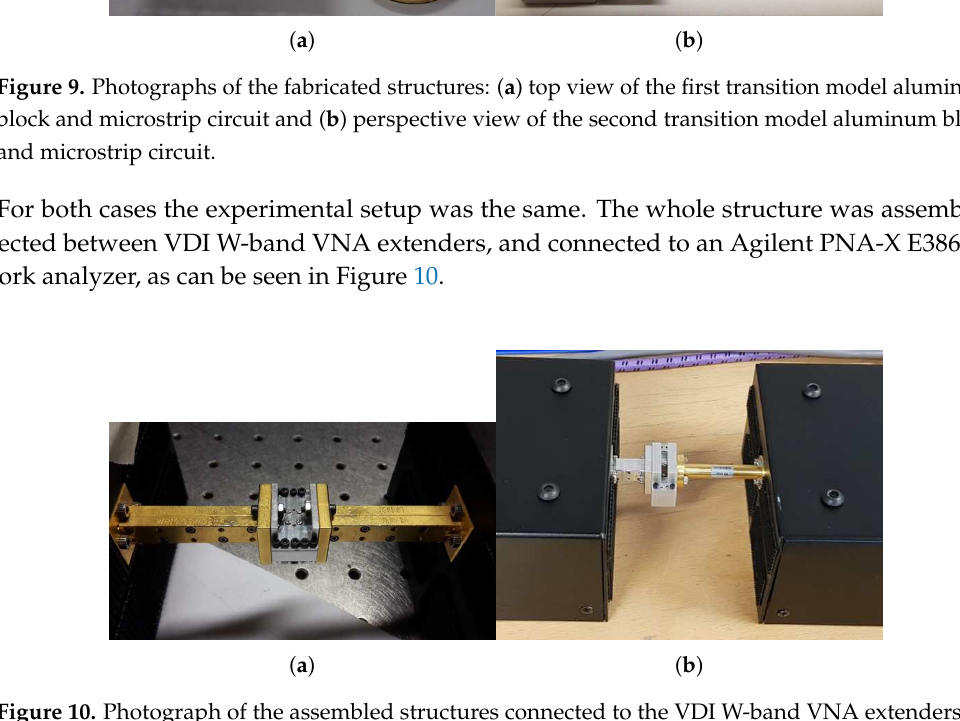
Figure 10. Photograph of the assembled structures connected to the VDI W-band VNA extenders for the first ( a ) and second models ( b